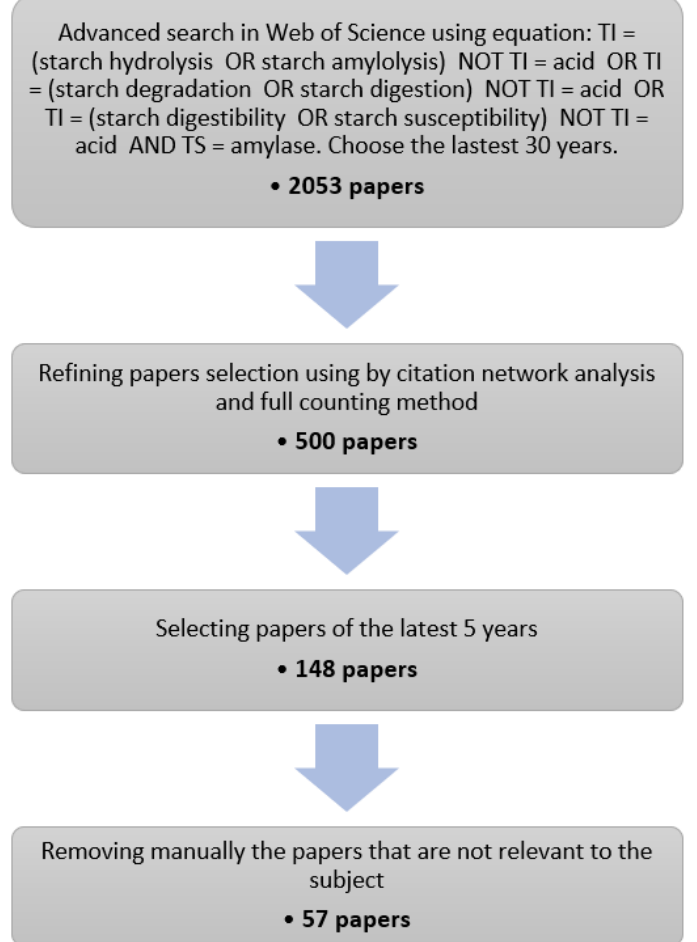
Figure 1. Flow chart for selecting relevant papers. TI and TS stand respectively for title and topic. While we have generally respected the PRISMA guidelines, several items related to data-extraction, meta-analysis and to the involvement of potentially many reviewers are not applicable for this work .